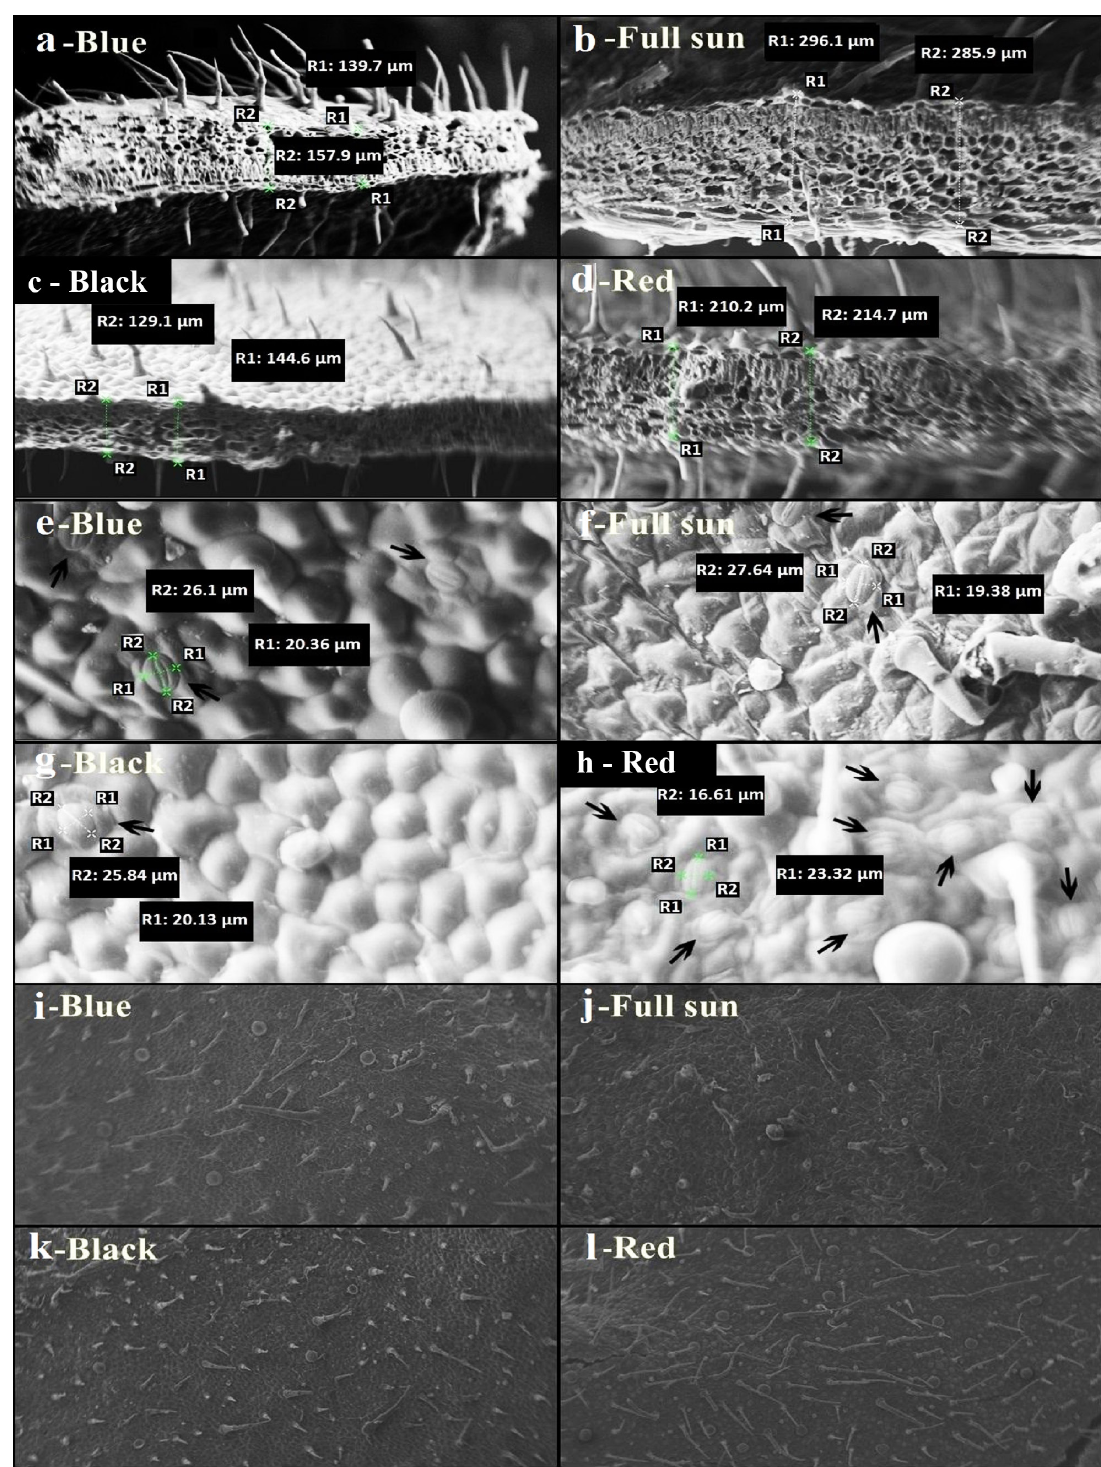
Figure 3 - Photomicrographs of P. cablin leaves grown under full sun and under colored shade nets at 50% irradiance. a - d ) Leaf blade thickness; e - h ) equatorial and polar diameter of stomata in the abaxial face; i - l ) number of trichomes in the abaxial face epidermis. Arrows showing the